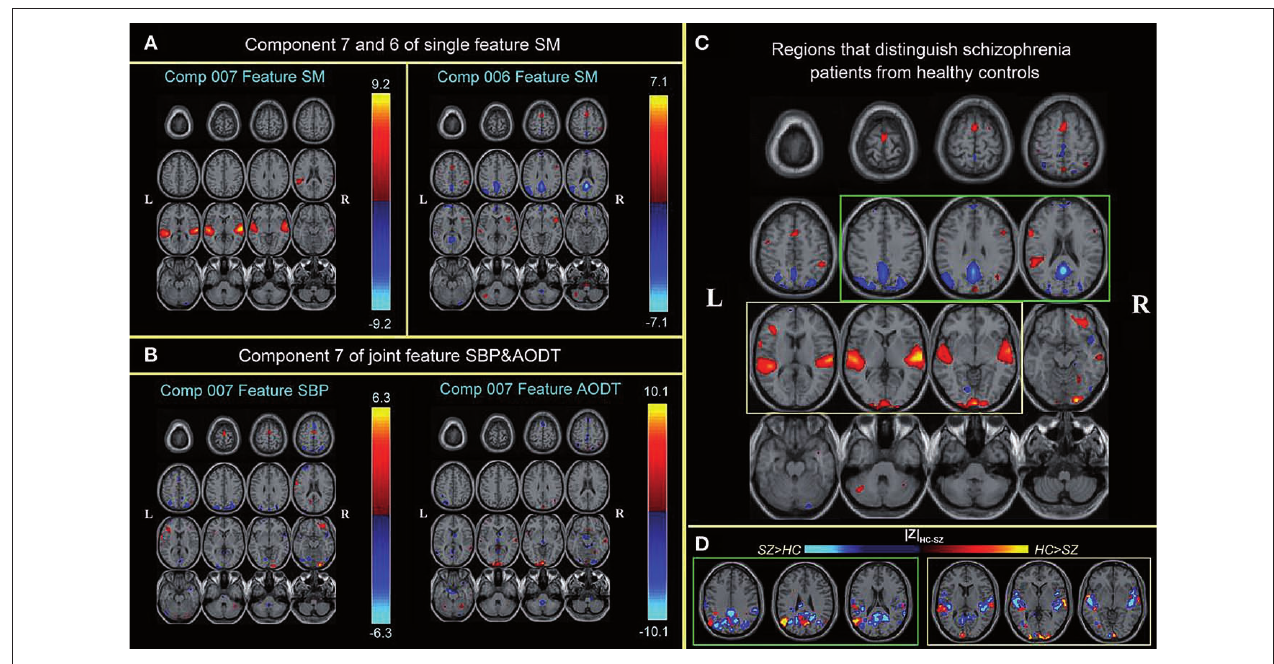
FIGURE 9 | Top three optimal components and the combined most group-discriminative regions (from Sui et al., 2009b). (A,B) are the spatial maps of the top three optimal components, which are converted to Z -scores and thresholded at | Z | > 2.5; (C) shows the overlapping regions of the four features with their original spatial map values, these activated regions are